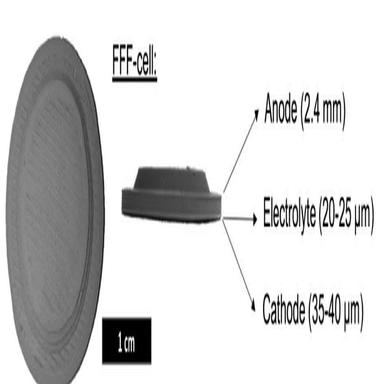
Ni-YSZ anode support, electrolyte and cathode schematically represented (thicknesses included in brackets) in the manufacture FFF-cell ready for the electrochemical characterization.